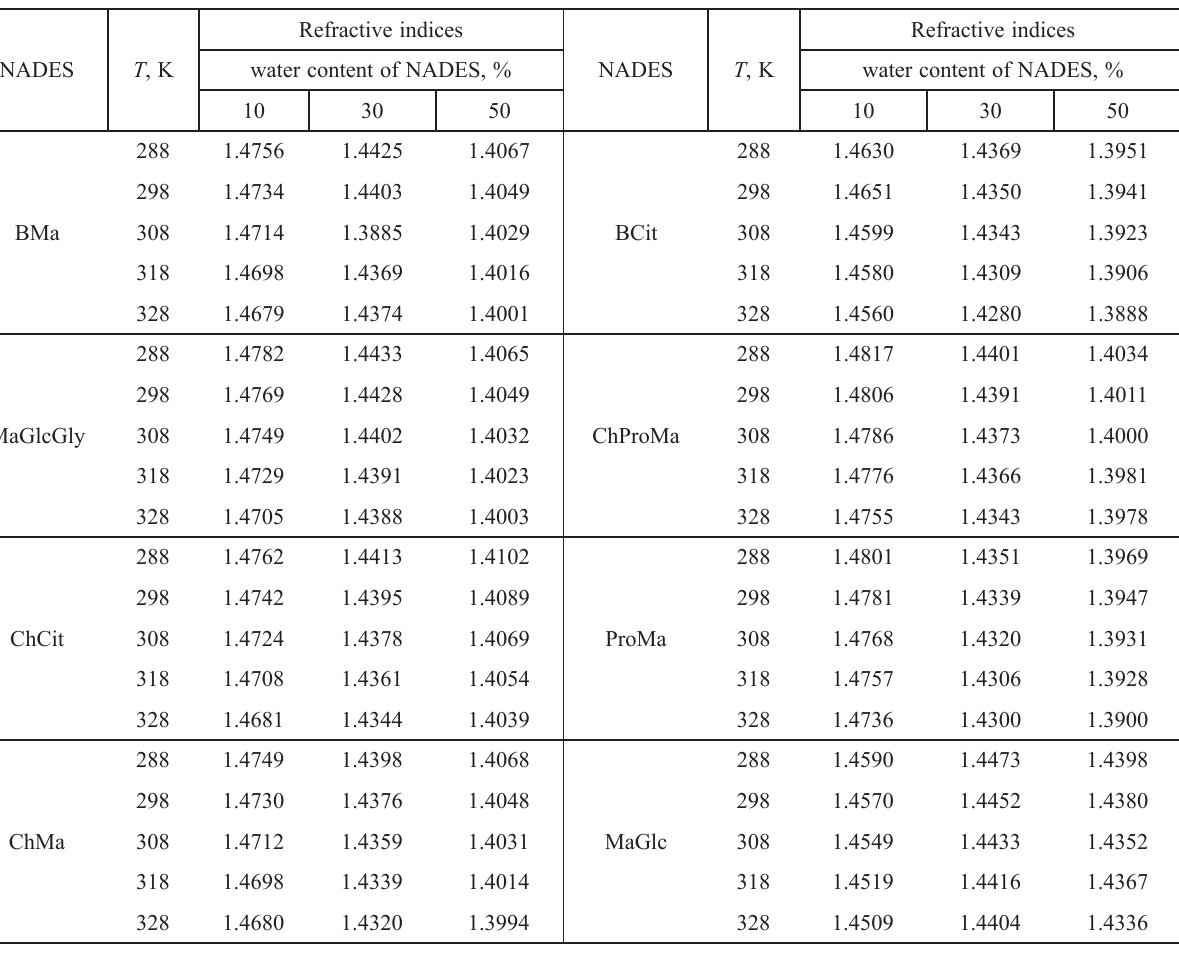
Table 2 – Refractive indices of NADES with different water contents 10–50 % (w/w) in the temperature range 288–328 K